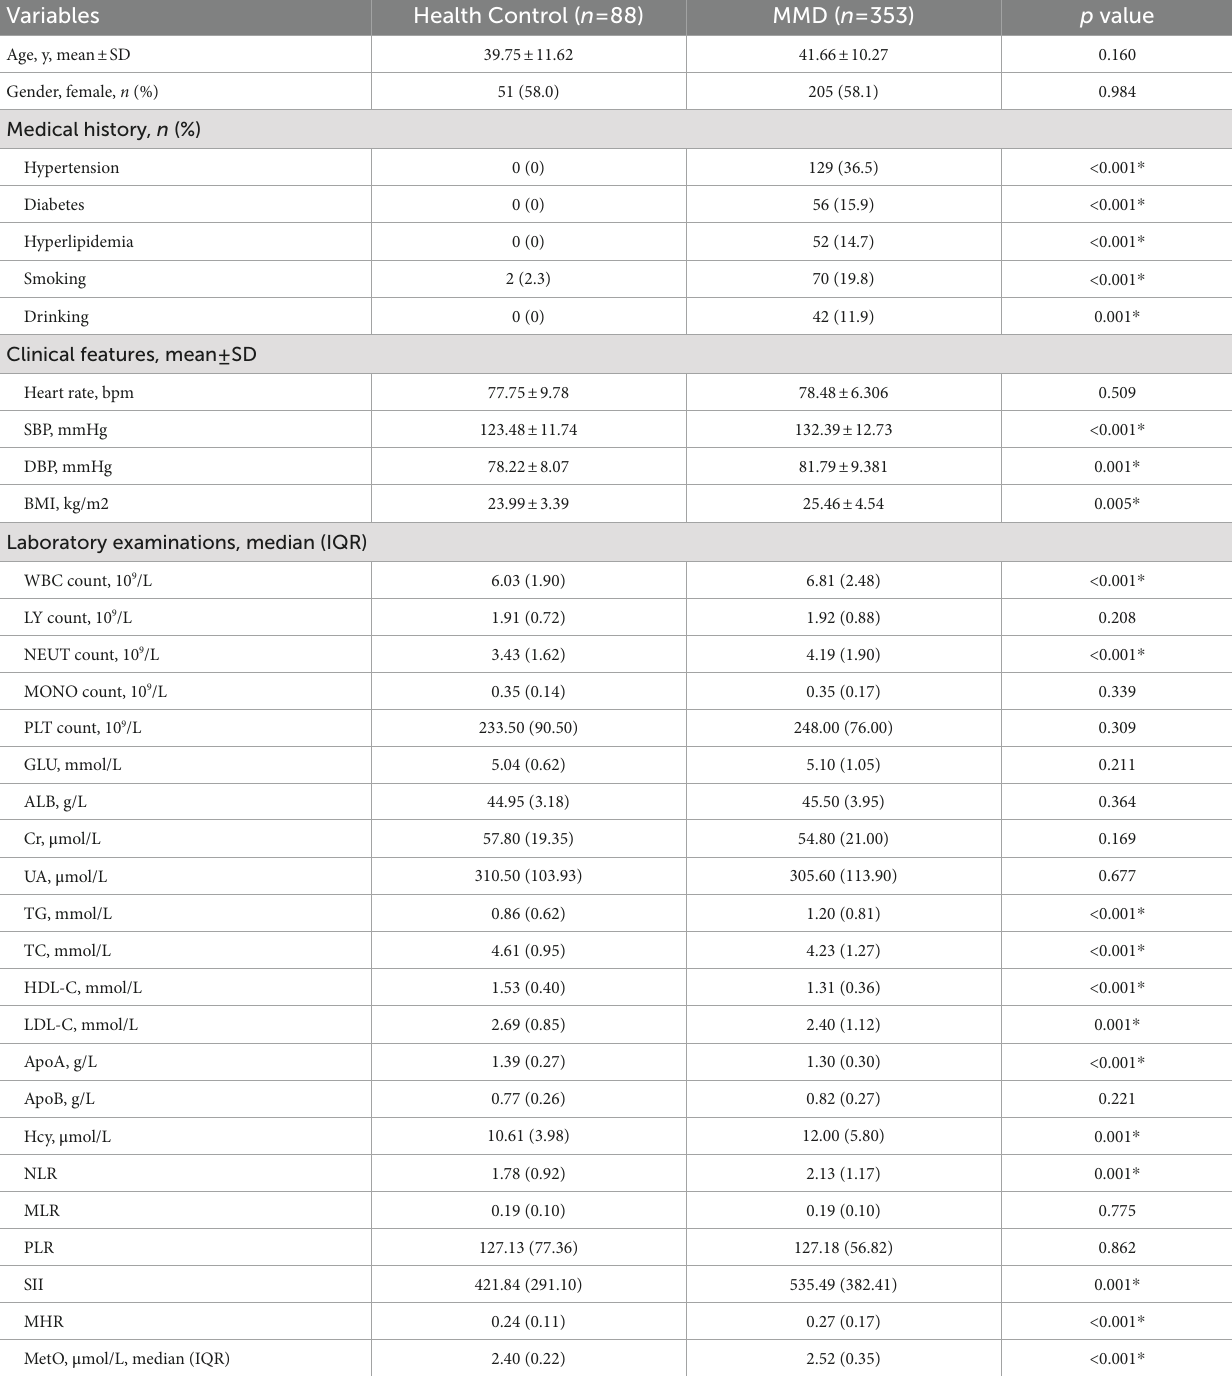
TABLE 1 Baseline characteristics between HC and MMD